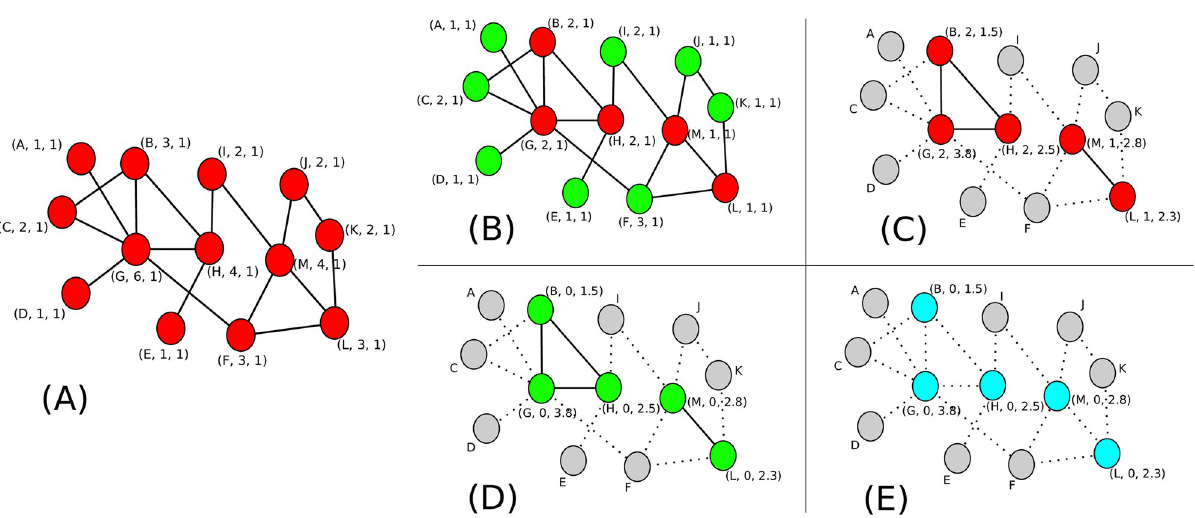
Fig 2. Demonstration of the AnB algorithm on a typical network. Panel (A) shows the initial state of a network of size 13. Panels (B) through (E) show the successive steps in the execution of the aggregate phase of the algorithm. The nodes in Active, Leaf, Residue and Inactive states are shown in red, green, cyan and grey colors respectively. The bracket beside each node shows the id i of the node, the number of its active neighbors e i , and its current local count c , as an ordered tuple. For inactive nodes, only the id of the node is shown because the quantities e i inactive state. Once the network reaches a state where only residue and inactive nodes are present in the network (as seen in Panel E), the AnB algorithm enters its broadcast phase and the individual local counts of the residue nodes are broadcast throughout the network.